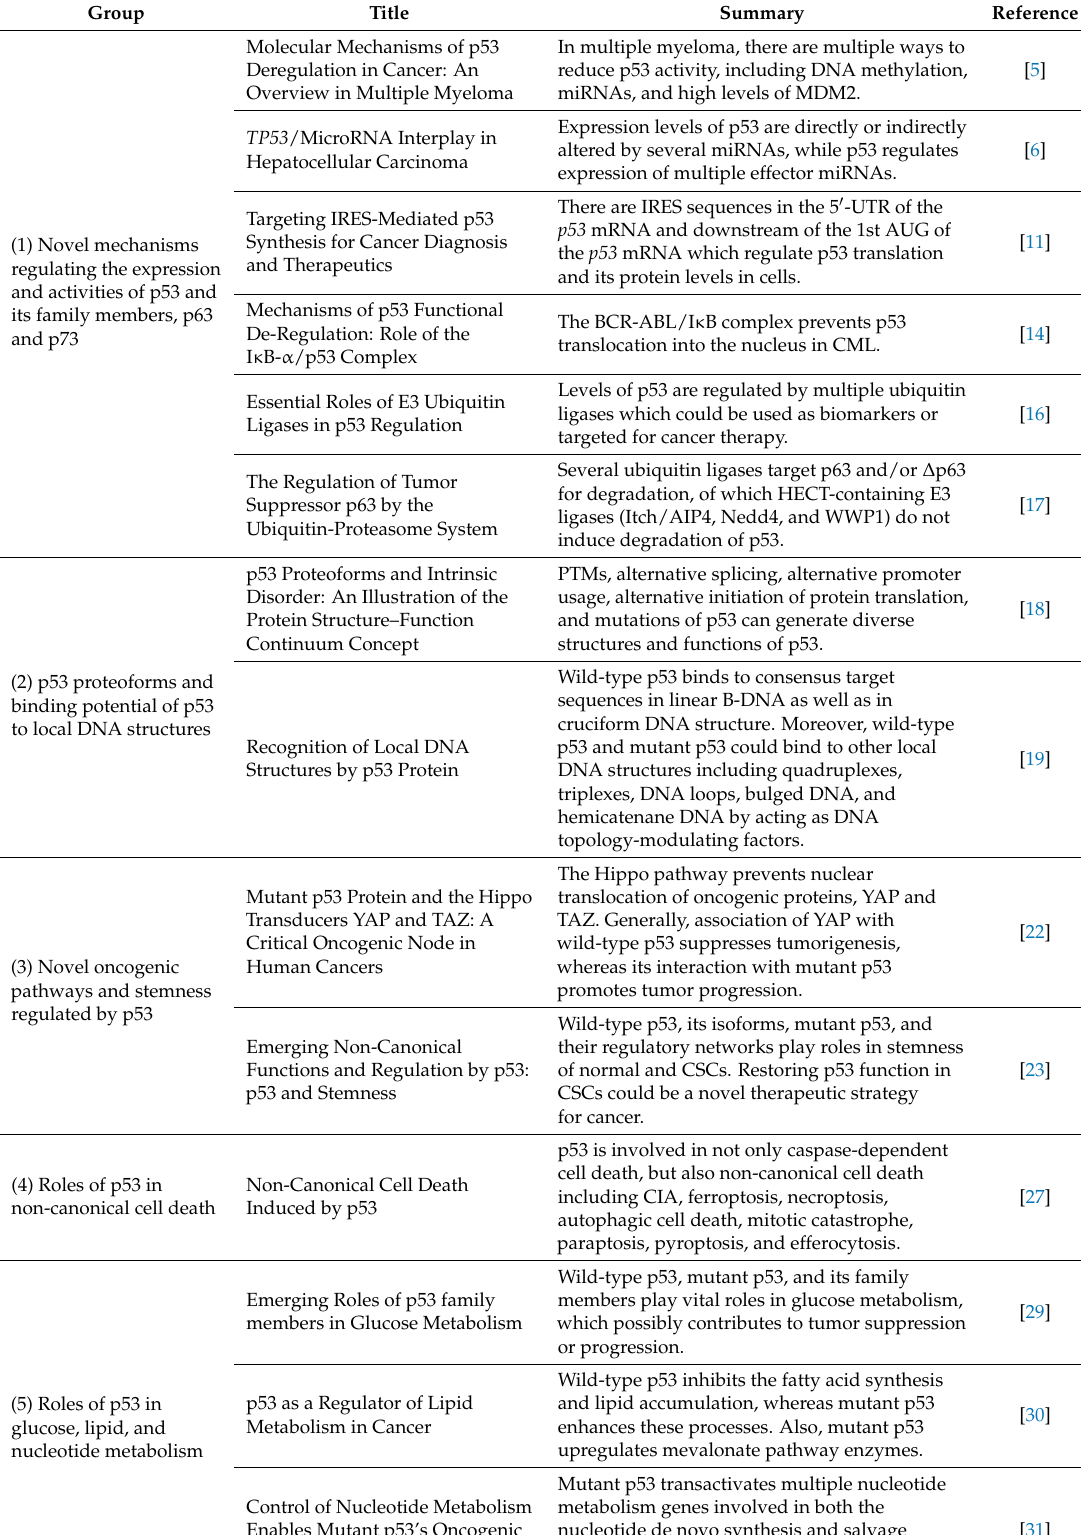
Table 1. Summary of papers in the Special Issue “Emerging Non-Canonical Functions and Regulation of